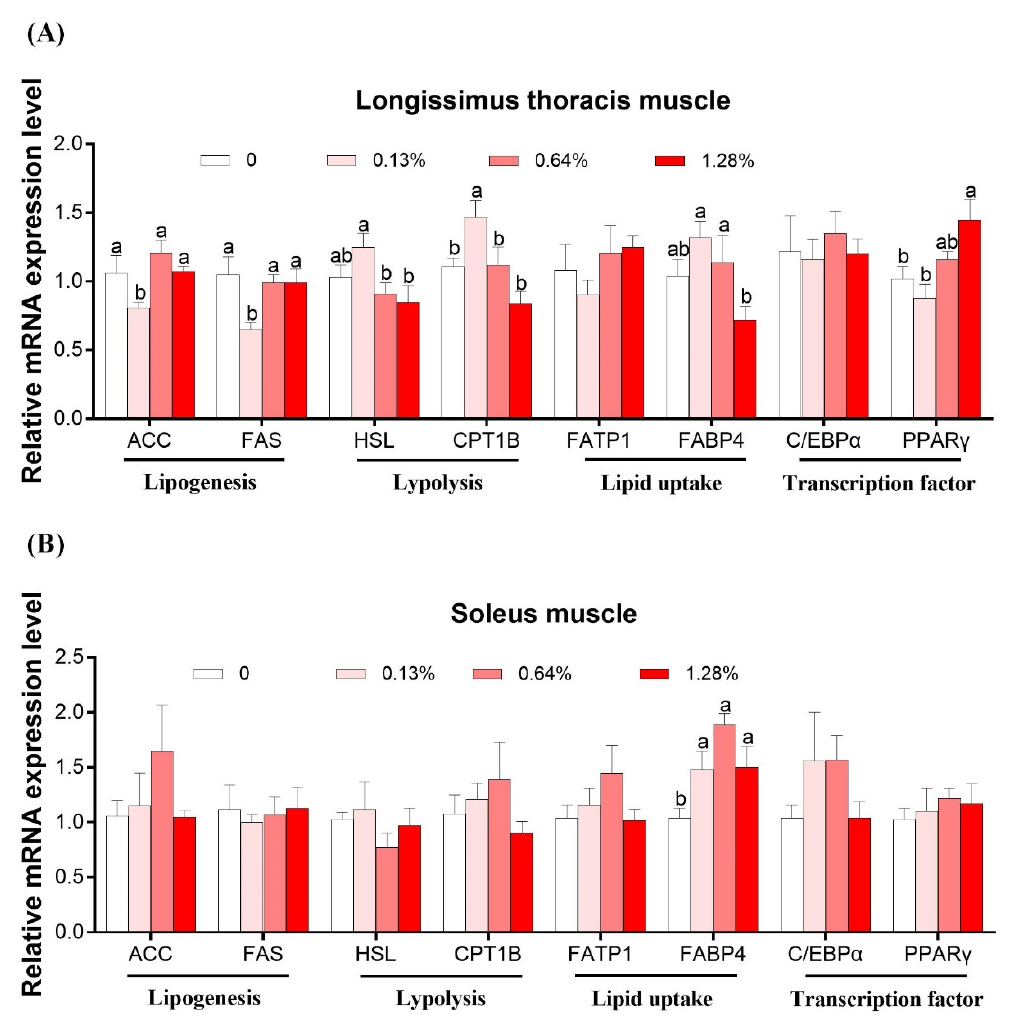
Figure 1. Effects of dietary HMB supplementation on the relative mRNA expression levels of genes in the Longissimus thoracis muscle ( A ) and soleus muscle ( B ) of the Bama Xiang mini-pigs ( n = 8). The real-time PCR method was employed, and β -actin was used as an internal control. Values are means, with their standard errors represented by vertical bars. a,b, Values within a row with different superscripts differ significantly ( p < 0.05).